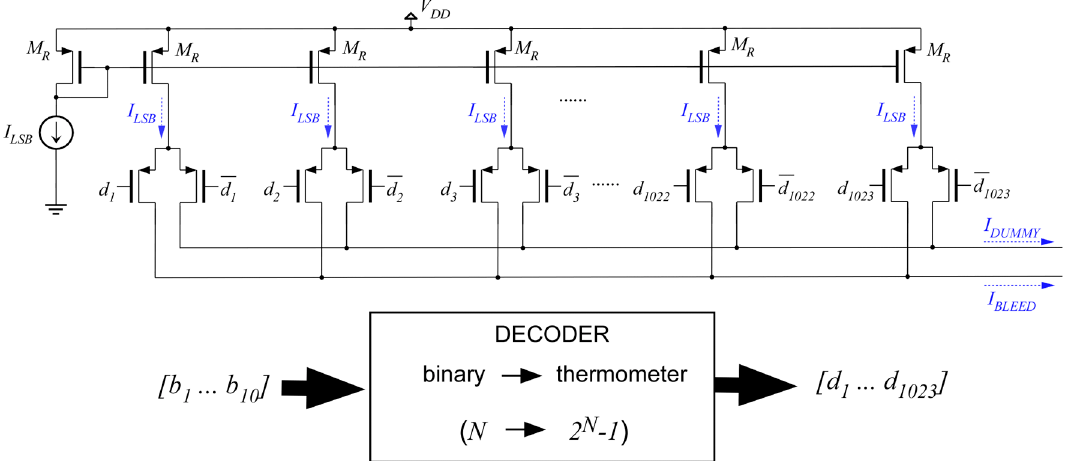
Figure 13. Scheme of the 10-bit current-steering DAC designed for the implementation of the bleeding current I BLEED (n), based on unary-weighted current sources.